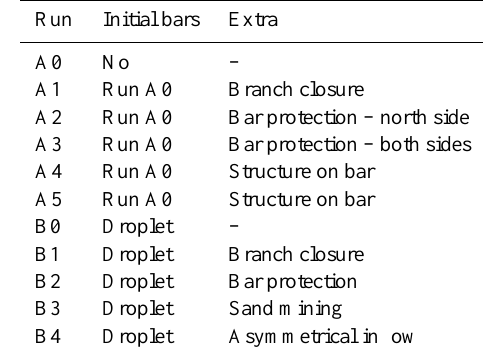
Table 1. Default initial and boundary conditions. Table 2. Model scenarios, also illustrated in Fig.